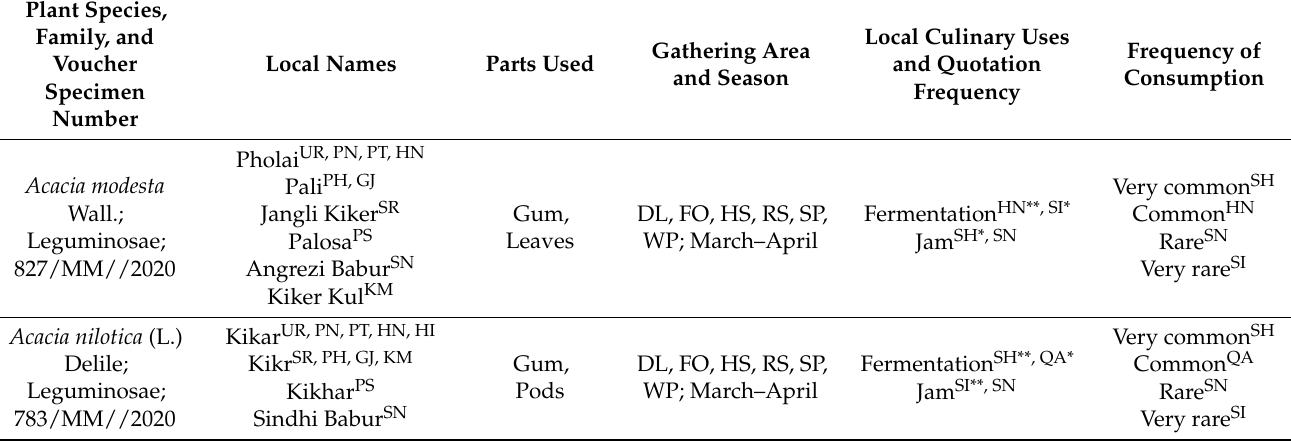
Table 2. Recorded wild food plants and their local